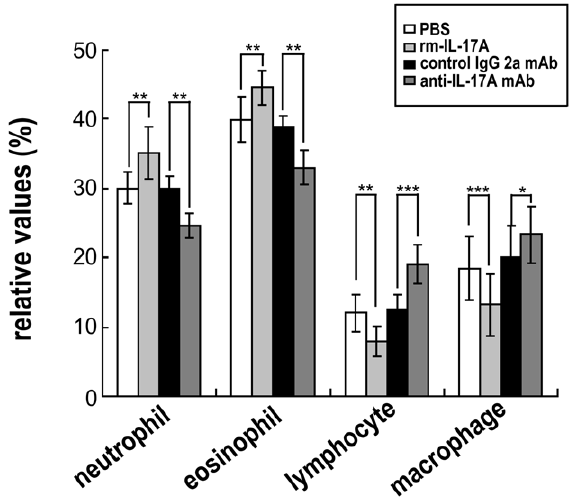
Figure 6. Percentages of granulomatous cells in S.japonicum infected mice administered rmIL-17A or anti-IL-17A neutraliz- ing mAb. rmIL-17A, anti-mouse IL-17A mAb or controls were administered to mice, followed by challenge with 40 S. japonicum cercariae per mouse. Six weeks after the challenge, the mice were sacrificed, and the livers were processed for H&E staining. Percentages of neutrophils, eosinophils, lymphocytes and macrophages in the granulomas were calculated by microscopic analysis of the same granulomas analyzed for lesion size by randomly counting 200 cells (not including hepatocytes) in each granuloma. Ten sections for each mouse and five microscope fields for each section were counted. Values are given as mean 6 SD of eight mice from two independent experiments. * P , 0.05; ** P , 0.01; *** P , 0.001, compared to control mice injected with PBS or isotype